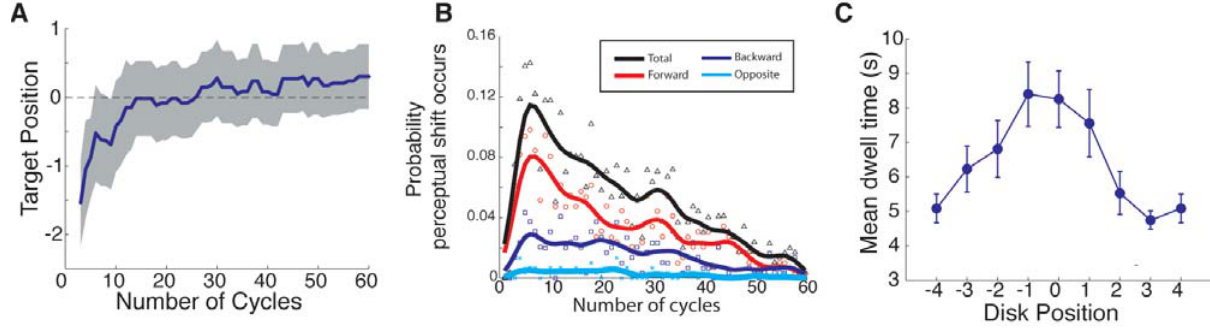
Figure 2. The basic characteristics of perceptual transitions in AV synchrony. A . The mean AV synchrony relative to the veridical position (n=10). Positive values indicate forward shifts of perceived audiovisual synchrony. The gray zone represents one standard error of the mean. The data are plotted from the third cycle onwards as there was no response in earlier cycles due to response latency. B . Probability that a transition occurs in the forward (step size: + 1, + 2, or + 3), backward (step size: 2 1, 2 2, or 2 3) or to the 180 u opposite position ( 6 4), which is directionally uncategorizable either as forward or backward, as a function of cycle number is shown. The black line is the probability sum of all transitions. The smooth curves are obtained by convolving the point (event) data with a Gaussian kernel ( s =2 cycles). C. The mean dwell time is plotted as a function of disk position. The error bars indicate one s.e.m. (n=10). synchrony. The dominance of the forward shift can be seen in Figure 2B: transitions occurred more frequently along the motion direction, especially for the early cycles of each trial.